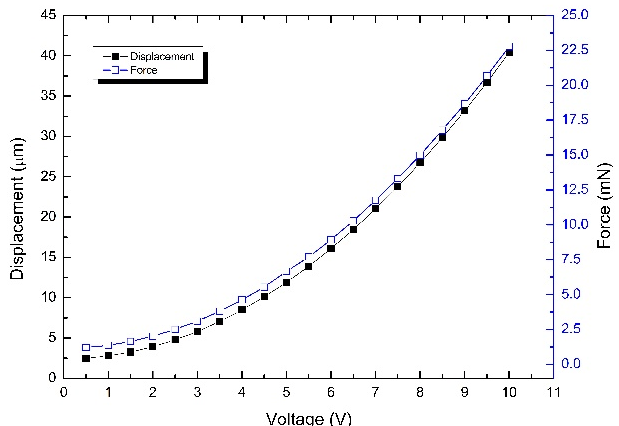
Figure 12. Displacement and force for IMG2.